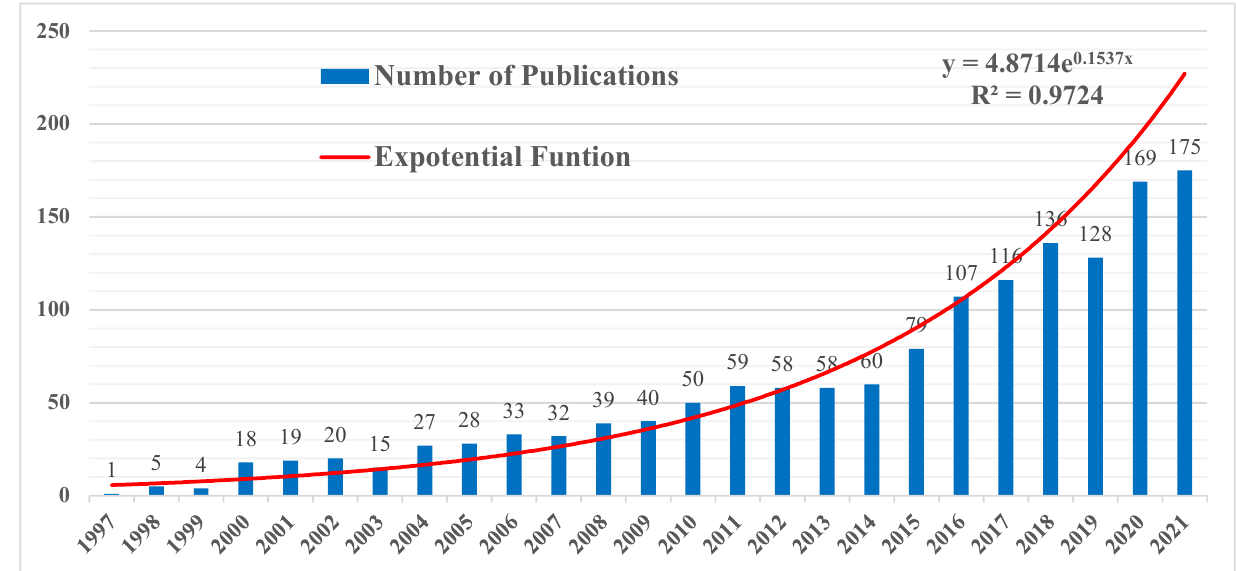
Figure 2. The annual number of publications related to the land trust field.